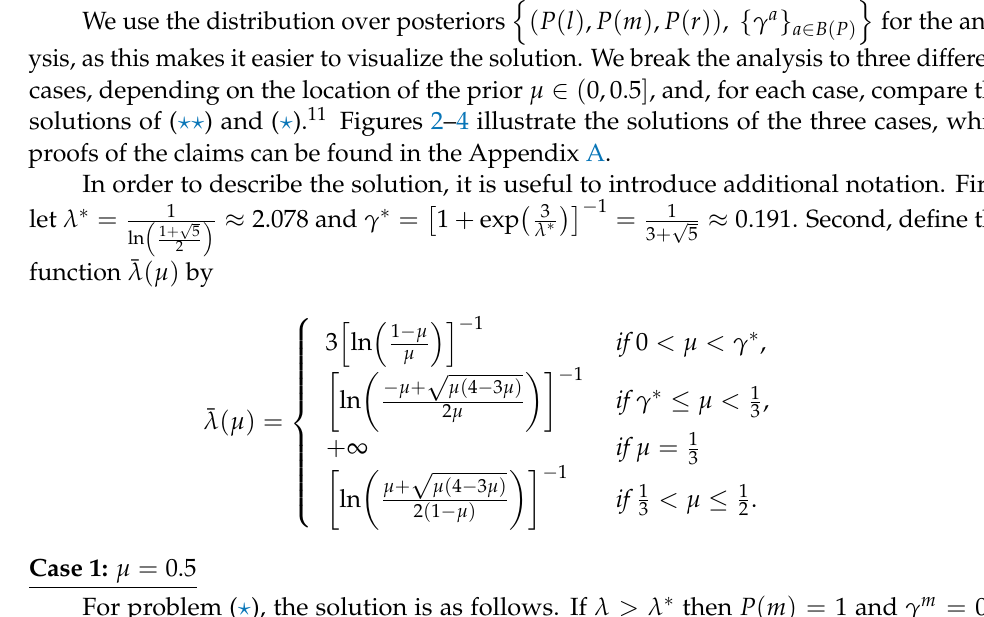
Figure 1. The dashed lines show the expected utility for each of the actions { l , m , r } in the example as a function of the decision maker’s (DM’s) belief. The upper envelope of these functions is the solid black line. l is optimal for posteriors in [ 0,1/3 ] , m is optimal in [ 1/3,2/3 ] , and r is optimal in [ 2/3,1 ]